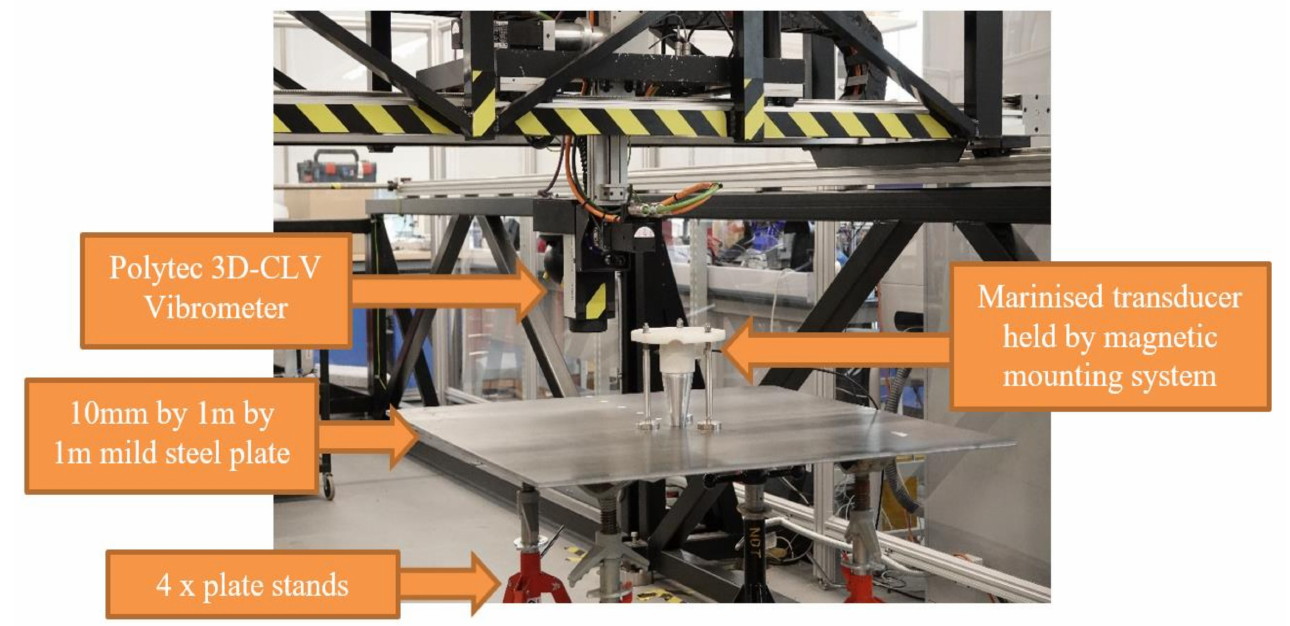
Figure 5. Experimental set-up plate and transducer with horn and magnetic mounting